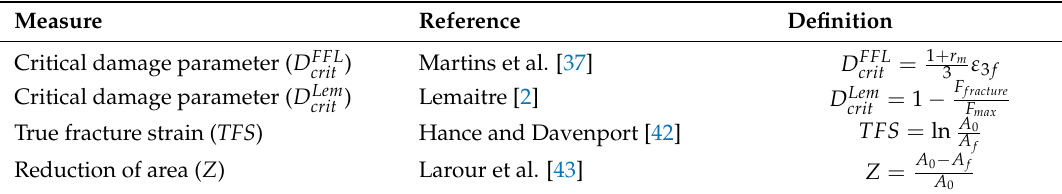
Table 4. Measures for local